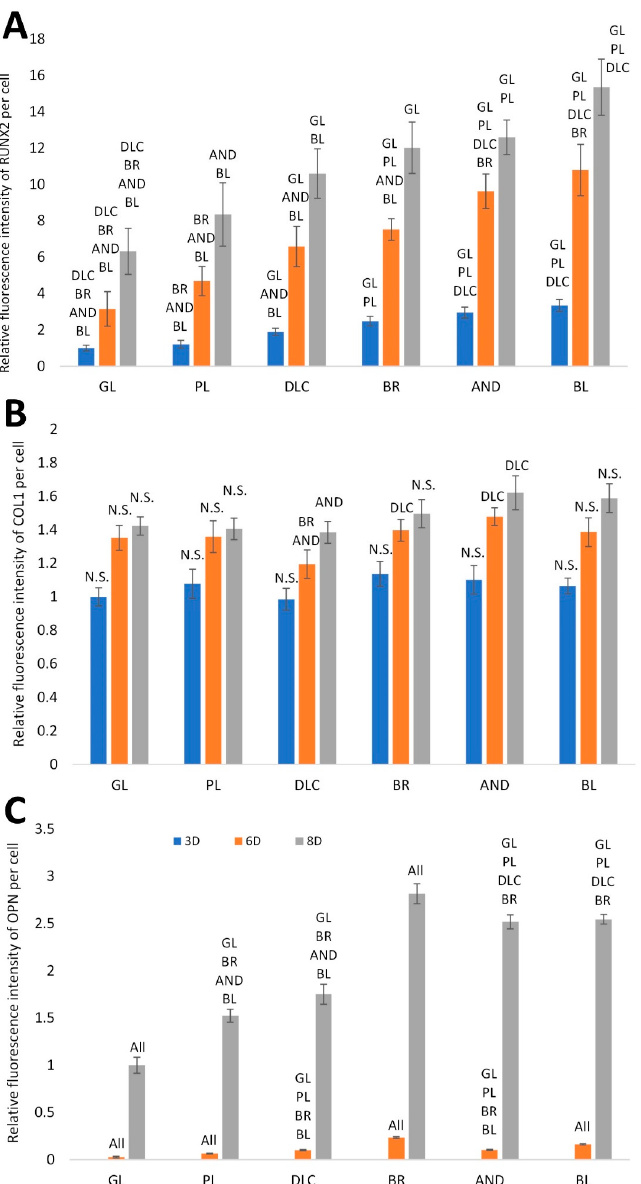
Figure 8. Relative fluorescence intensity of osteogenic markers RUNX2 ( A ), COL1 ( B ) and OPN ( C ) in cells on days 3, 6, and 8 of cultivation on the reference glass coverslips (GL) and on the Ti6Al4V samples modified by polishing (PL), by DLC-coating (DLC), by brushing (BR), by anodizing (AND), or by blasting (BL). Average ± SD from three samples, ANOVA, statistical significance ( p ≤